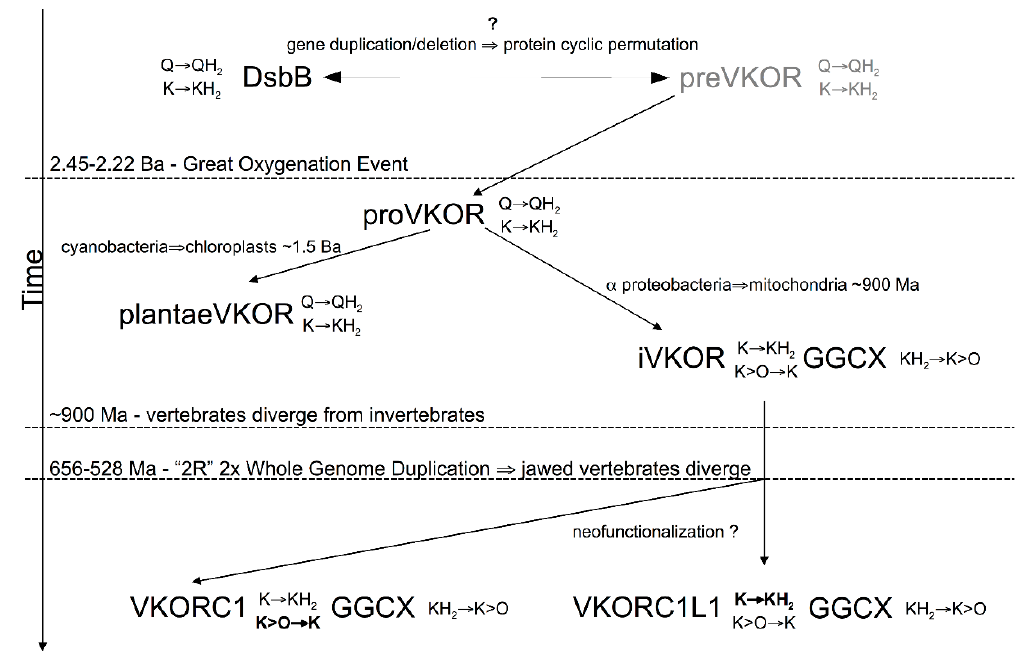
Figure 7. A comprehensive model for the evolution of the VKOR family and its hypothesized relationship to the DsbB family, suggested by the close relationship between the structure of the present reconstructed VKOR family phylogeny and that of the current consensus for the Tree of Life. Abbreviations and symbols (except if previously